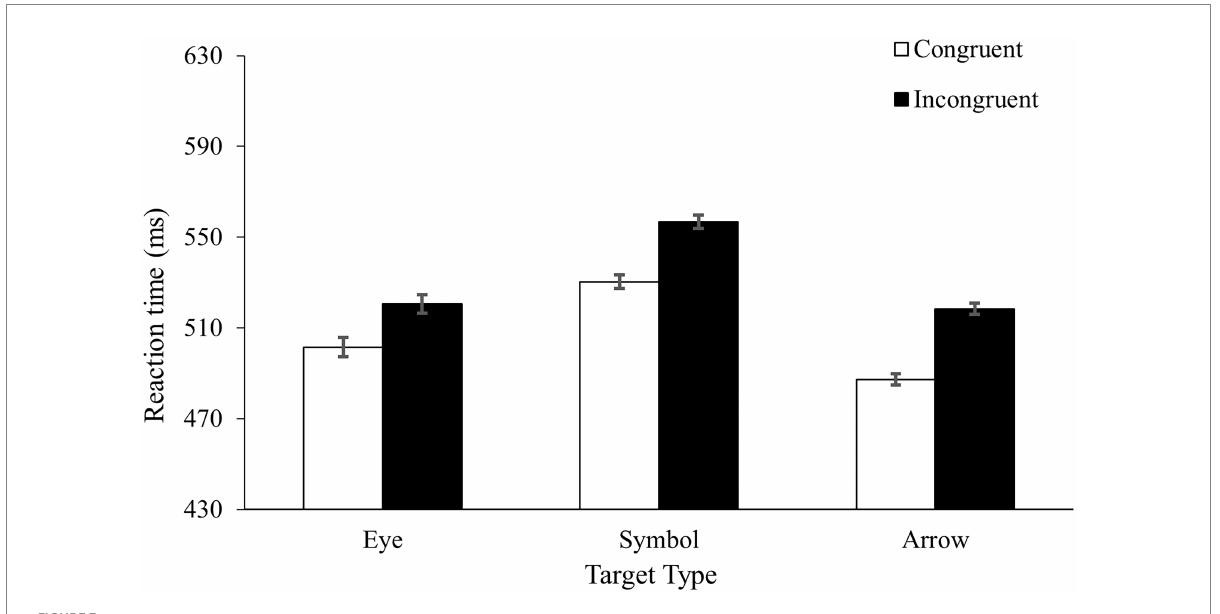
FIGURE 3 Results from Experiment